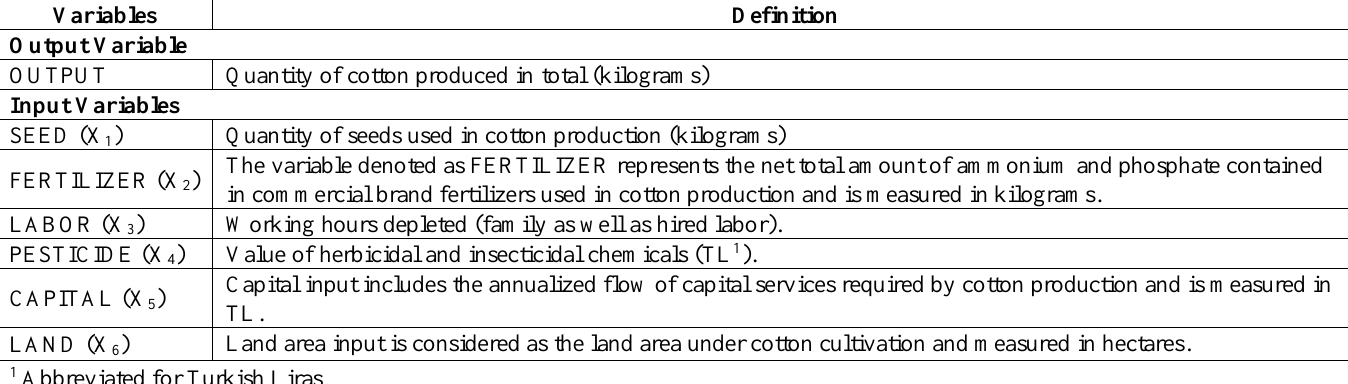
Table 1: Definition of the variables used to estimate frontier production